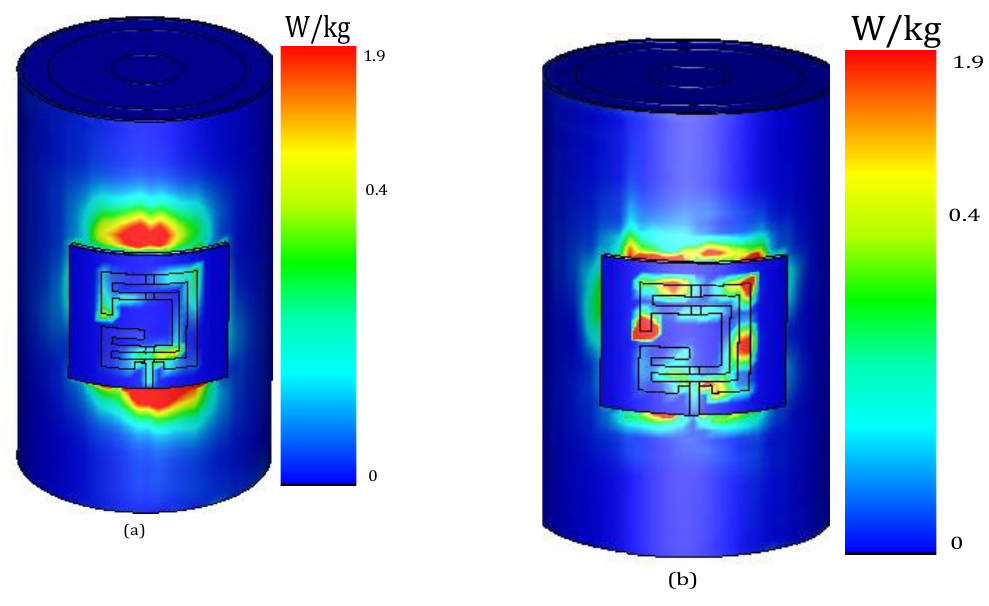
Figure 24. Conventional antenna’s SAR value on a child’s arm (worst case) of radius 40 mm at ( a ) 2.5 GHz and ( b ) 5.2